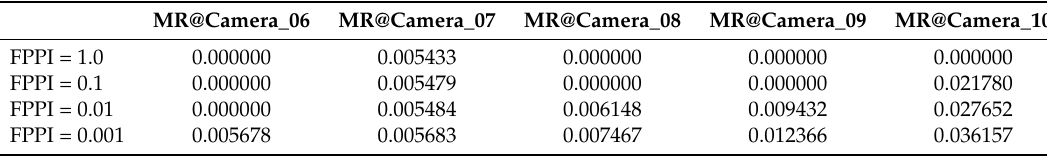
Table 3. Accuracy table @ Cameras_06–10,